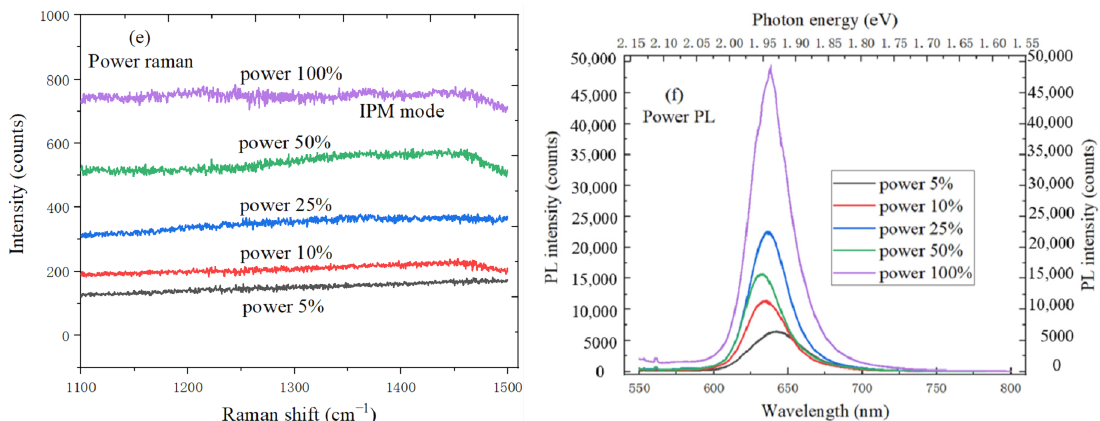
Figure 10. Spectral characteristics of WS 2 /h-BN heterostructure ( a ) Raman characteristic peaks of h-BN ISM mode and MoS 2 at four different teat points; ( b ) IPM mode characteristic peaks of h-BN at four different teat points; ( c ) PL spectrum of WS 2 /h-BN heterostructure at four different teat points; ( d ) power Raman characteristic peaks of h-BN ISM mode and MoS 2 ; ( e ) IPM mode power characteristic peaks of h-BN; ( f ) power PL spectrum of WS 2 /h-BN heterostructure.